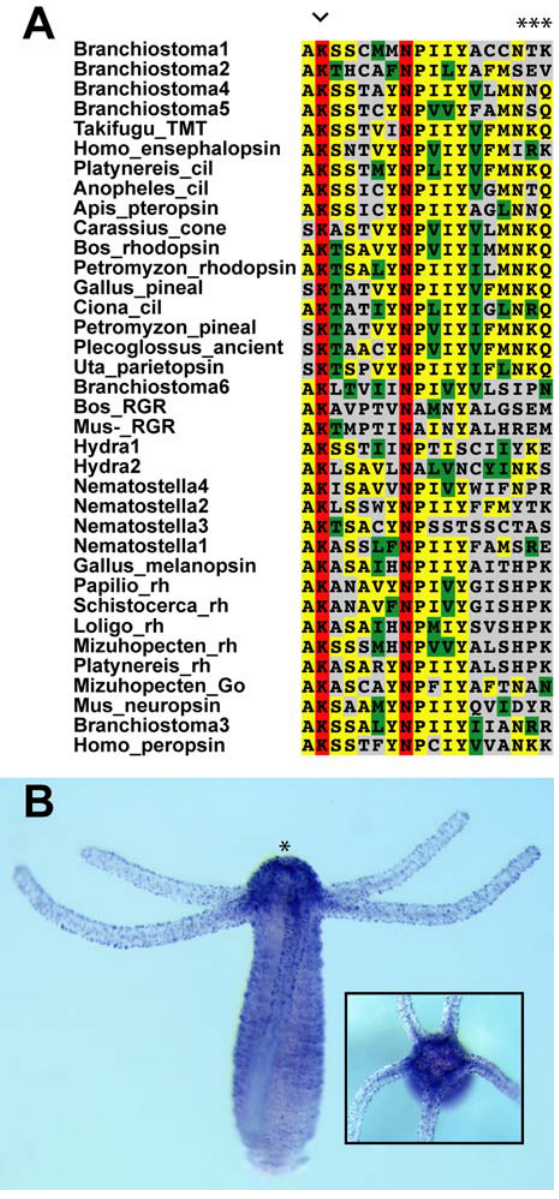
Figure 1. Sequence motifs and expression of cnidarian opsin in the nerve net of Hydra magnipallata. (A) Sequence alignment of 4 th cytoplasmic loop region of animal opsins used in this study indicating the Lys 296 chromophore binding site (arrowhead) and the G protein- binding tripeptide (asterisks). (B) In situ hybridization with Hm2 cnidops probe. Asterisk denotes the hypostome. Opsin is expressed most strongly in a ring of sensory neurons that surround the mouth. Inset, oral